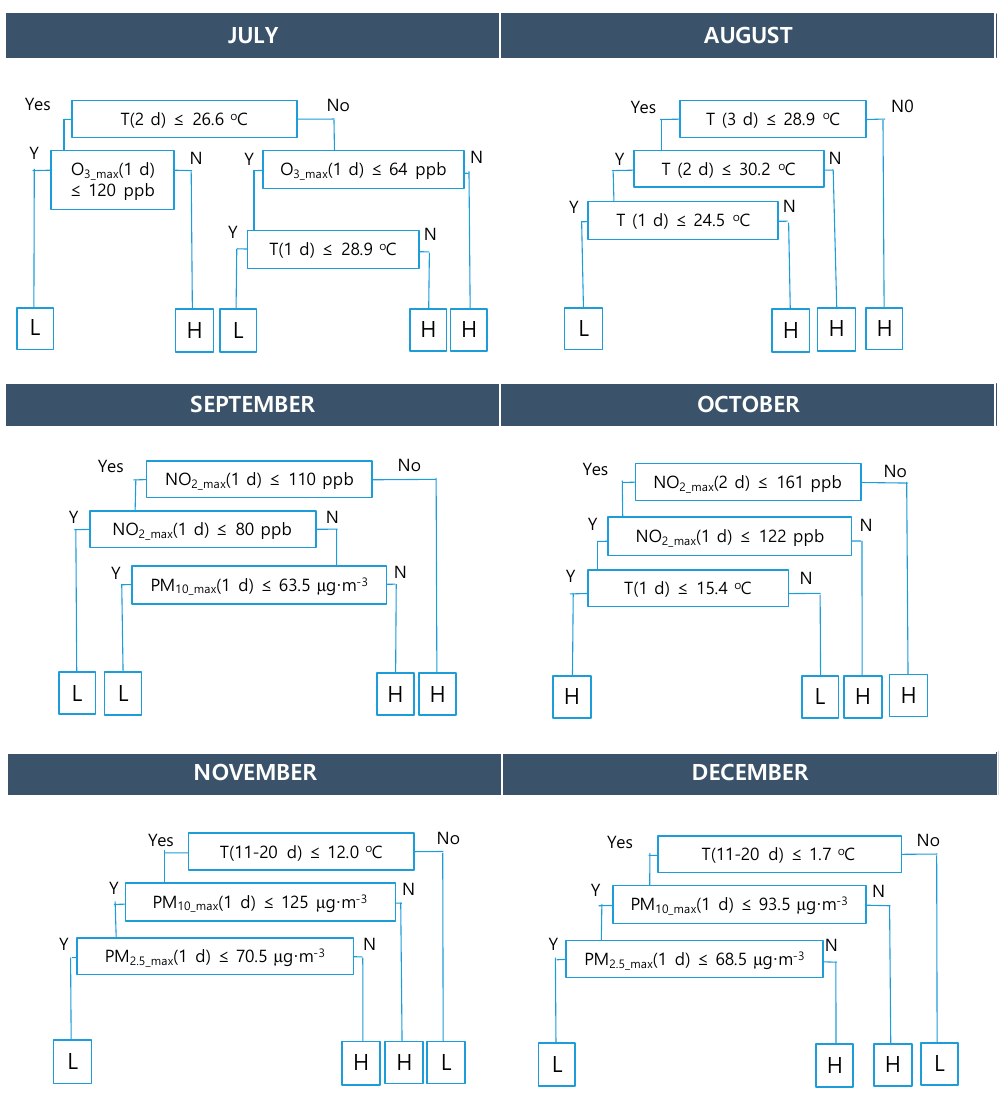
Figure 8. Hourly maximum pollutant concentrations and temperature affecting the high (H) and low (L) probability of death from respiratory disease.